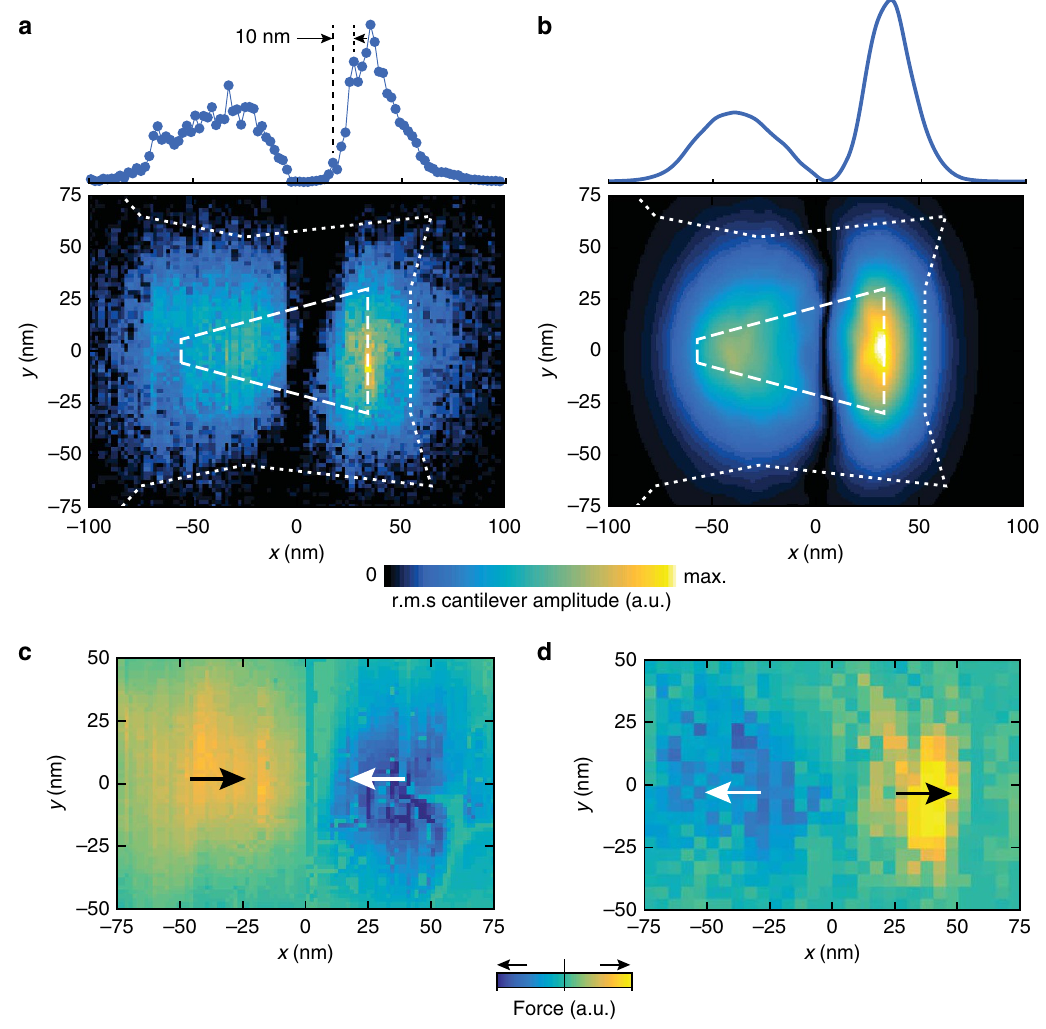
Figure 4 | Two-dimensional imaging of pole field. ( a ) Experimental force image recorded with tip A. Two lobes of increased signal are visible at the front and back ends of the pole where the gradient q x | B | is largest. The contours indicate the write pole (dashed) and shield (dotted). The traces above the image shows the signal intensity (r.m.s. squared cantilever oscillation) along the x direction. Point spacing is 2nm with an integration time of 3s per point. Drive current was 5mA. ( b ) Independent finite element simulation based on the micrograph from Fig. 1d. ( c , d ) Phase-sensitive force images recorded by a paramagnetic Pt-coated tip A ( c ) and by the diamagnetic bare diamond tip B ( d ), demonstrating that the sign of w can be detected. Arrows point in the direction of the force. Colour bar scale is linear. Scan height was 15nm for tip A and 30nm for tip B, and drive was